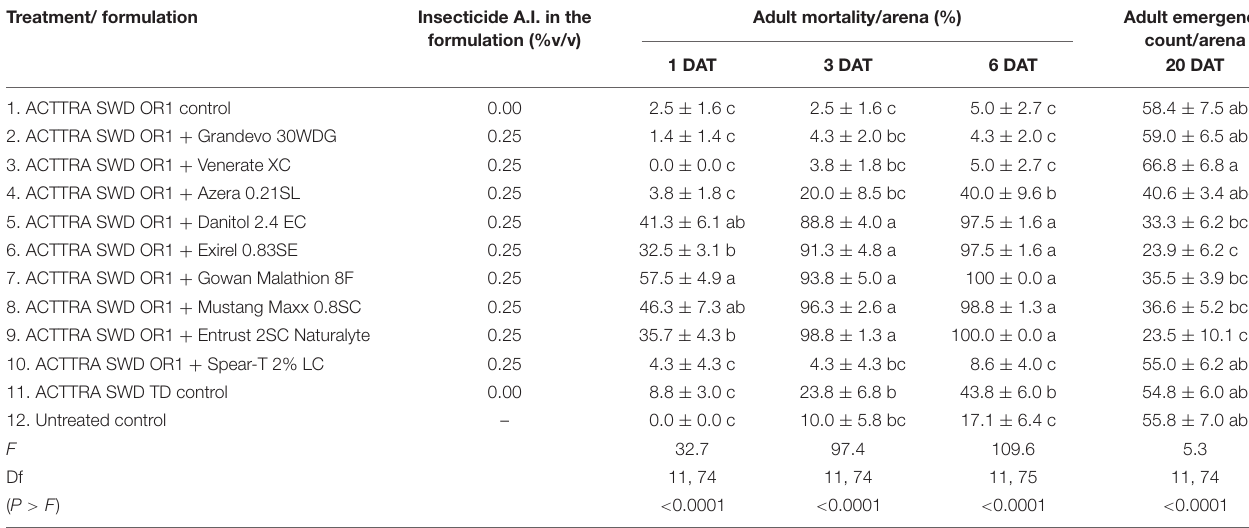
TABLE 2 | Percent adult Drosophila suzukii mortality (mean ± SEM), 1, 3, and 6 days after exposing the insects to various ACTTRA SWD OR1 + insecticide formulations and controls treatments and the mean ( ± SEM) counts of adult D. suzukii emerged 20 DAT, from the blueberries incubated from the bioassay arena. Treatment/ formulation